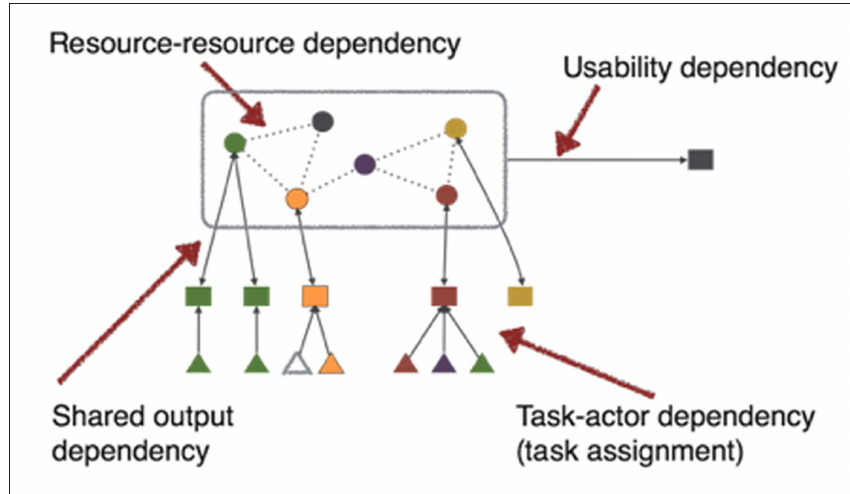
Figure 4: Expected structure of dependencies in writing a